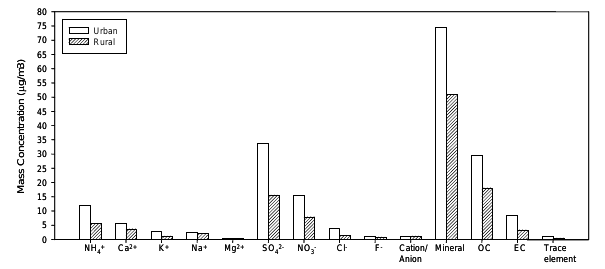
Fig. 3. Annual averaged mass concentrations of various chemi- cal species in urban and rural aerosols in China. The balance be- tween cations and anions (cation/anion) are expressed in micro- equivalents per cubic meter in this